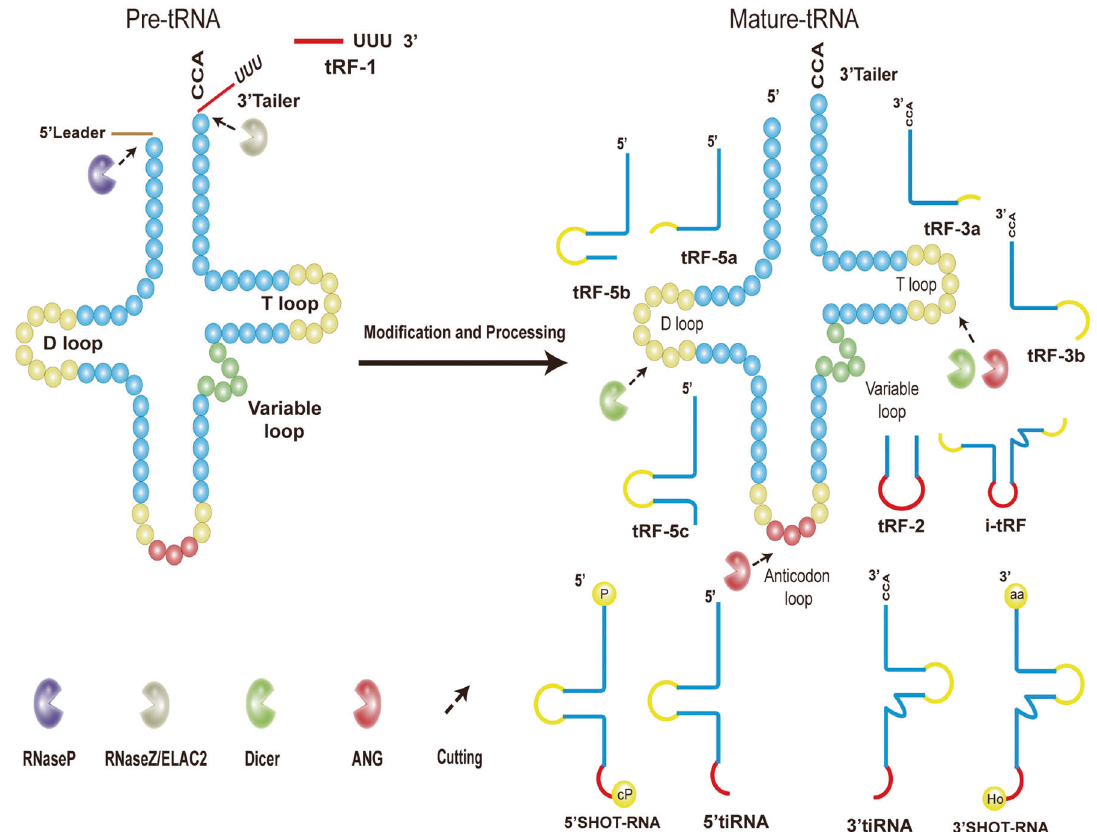
Fig. 1 Biogenesis and classi fi cation of tsRNAs. tRF-1 is produced by RNaseZ/ELAC2 cleavage of the 3 ’ trailer sequence of the precursor tRNA. tRF-2 contains the stem sequence and the anticodon loop portion of the mature tRNA. tRF-3 is the 3 ’ end fragment of tRNA produced by cleavage of the mature tRNA T-loop by nucleases. tRF-5 is produced by Dicer enzyme cleavage of the D-loop of mature tRNA. 5 ’ tiRNA and 3 ’ tiRNA are 5 ’ and 3 ’ fragments of mature tRNA produced by cleavage from the anticodon loop, respectively. The 5 ’ -SHOT-RNAs are half of the 5 ’ end of the tRNA with phosphate at the 5 ’ end and a cyclic phosphate (cP) at the 3 ’ end. 3 ’ -SHOT-RNAs contain half of the 3 ’ tRNA with a hydroxyl group at the 5 ’ end and an amino acid at the 3 ’ end. The i-tRF is a fragment containing the tRNA anticodon loop and the D- and